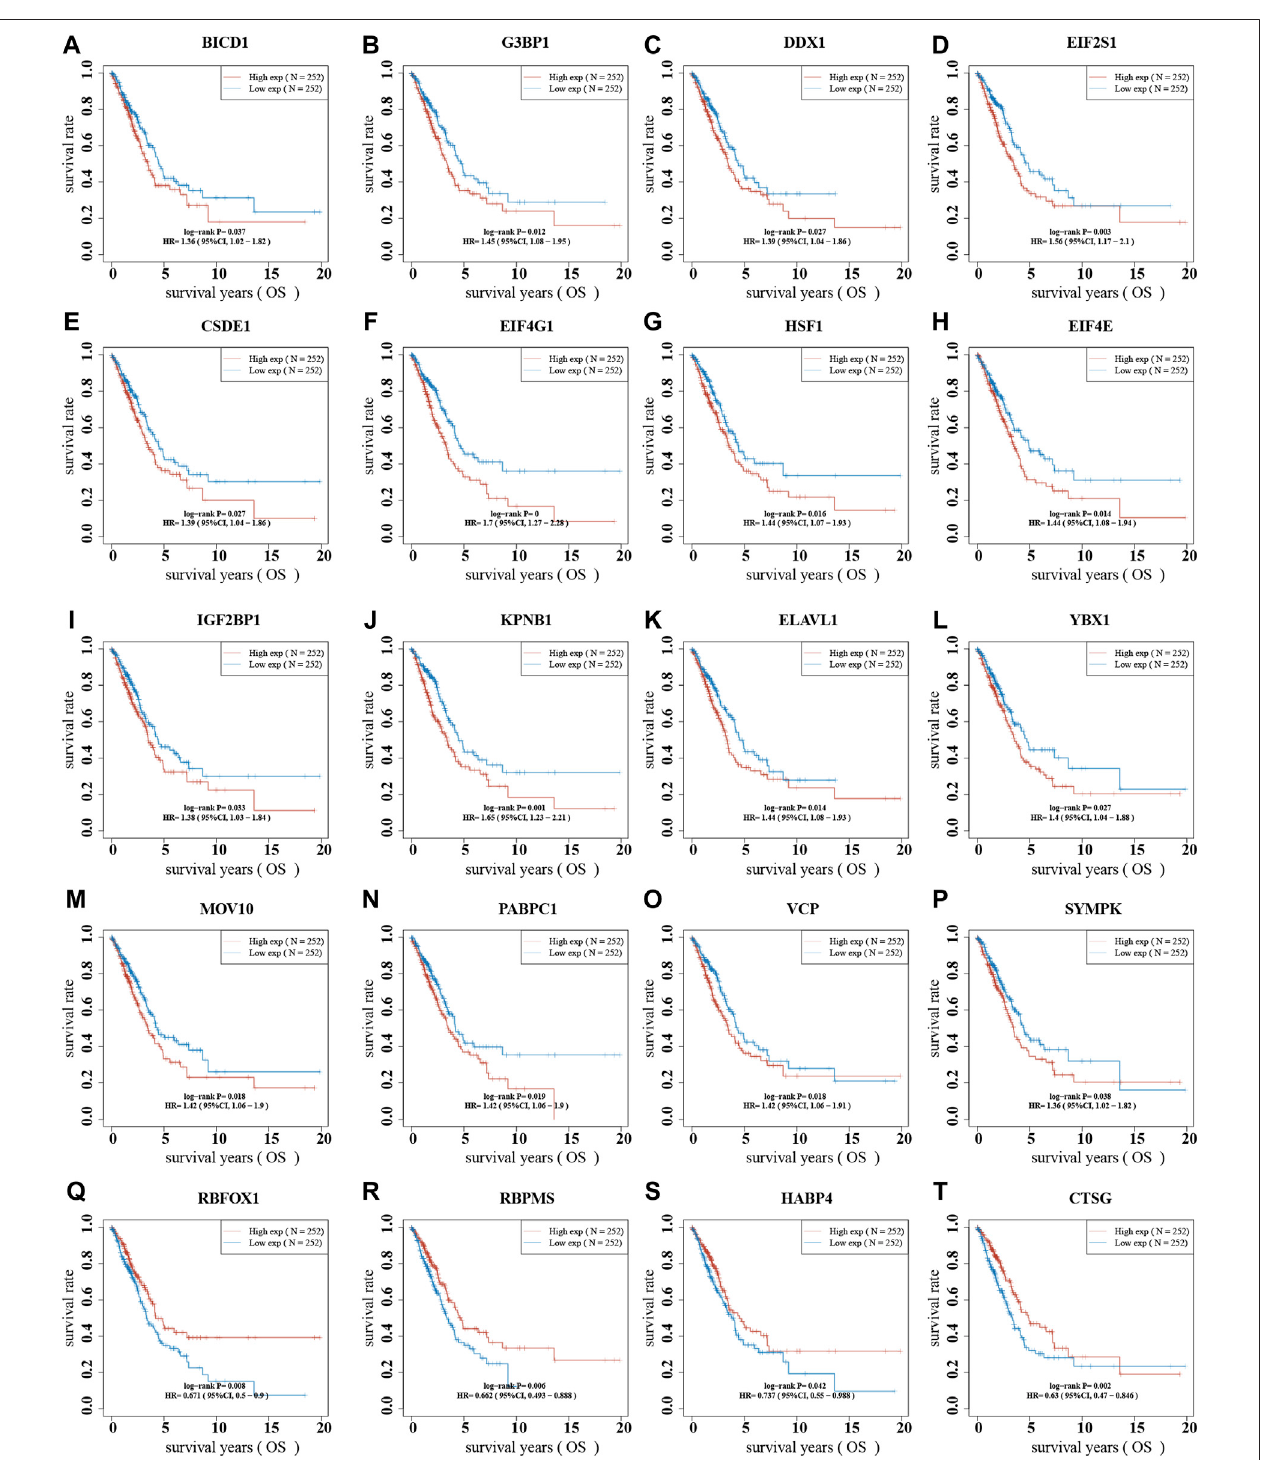
FIGURE 10 | The dysregulation of stress granule regulators was related to the poor prognosis of NSCLC. (A – T) The correlation between stress granule regulator expressionandoverallsurvivaltimeinNSCLCwereanalyzed,includingSYMPK,BICD1,IGF2BP1,CSDE1,DDX1,YBX1,PABPC1,MOV10,VCP,HSF1,ELAVL1,SSB, EIF4E, G3BP1, EIF2S1, KPNB1, EIF4G1, CTSG, RBPMS, RBFOX1, and HABP4.